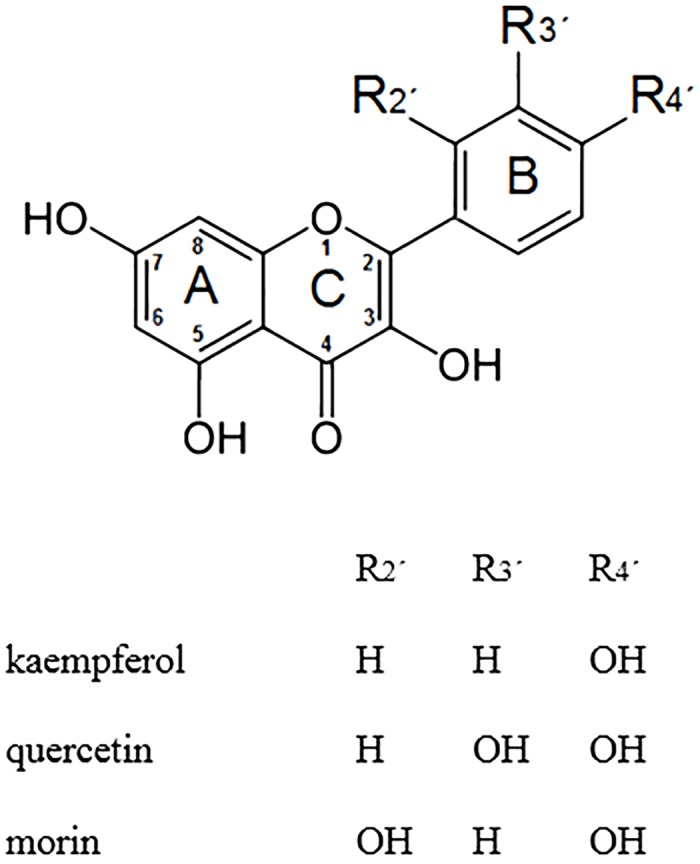
Chemical structures of flavonoids studied.